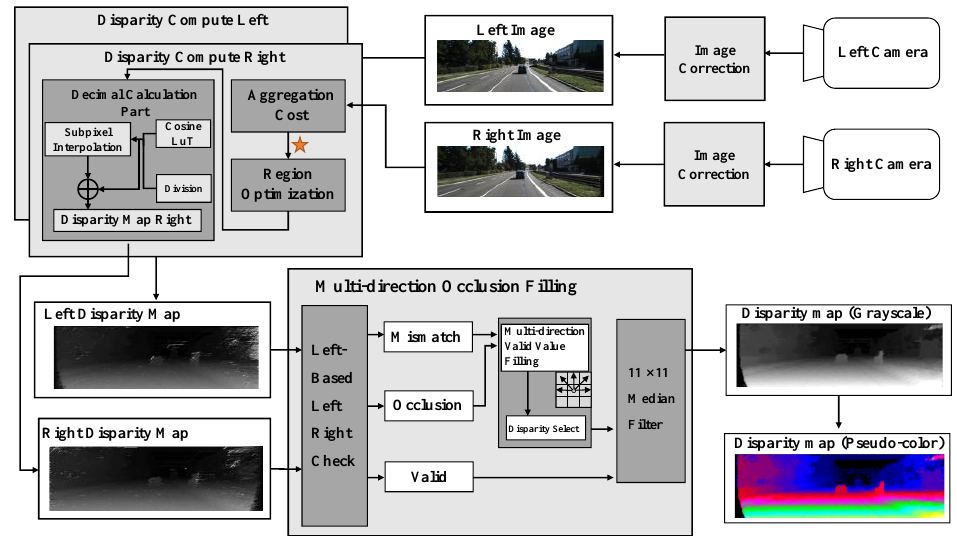
Figure 1. The overall framework of disparity refinement.